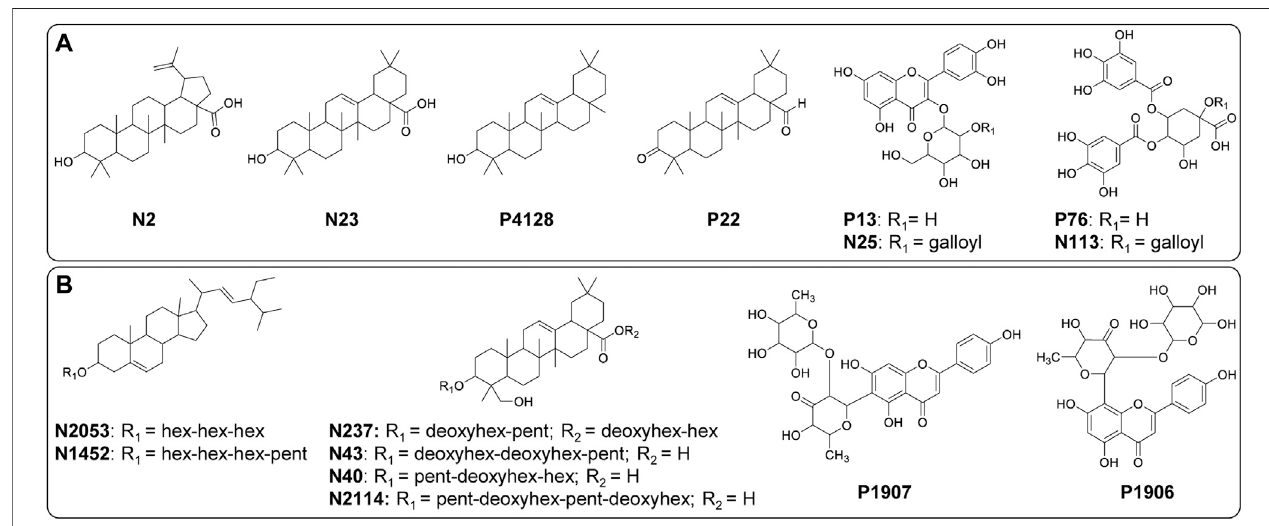
FIGURE7| Structuresofsigni fi cantmetabolites(FDR ≤ 0.05)forthedifferentiationof( A ) B.intermedia ( N2 , N23 , P4128 , P22 , P13 , N25 , P76 and N113 )and( B ) S. marginata ( N2053 , N1452 , N237 , N43 , N40 , N2114 , P1907 and P1906 ) harvests. Annotation of the metabolites is provided in the Supplementary Tables 7 and 9